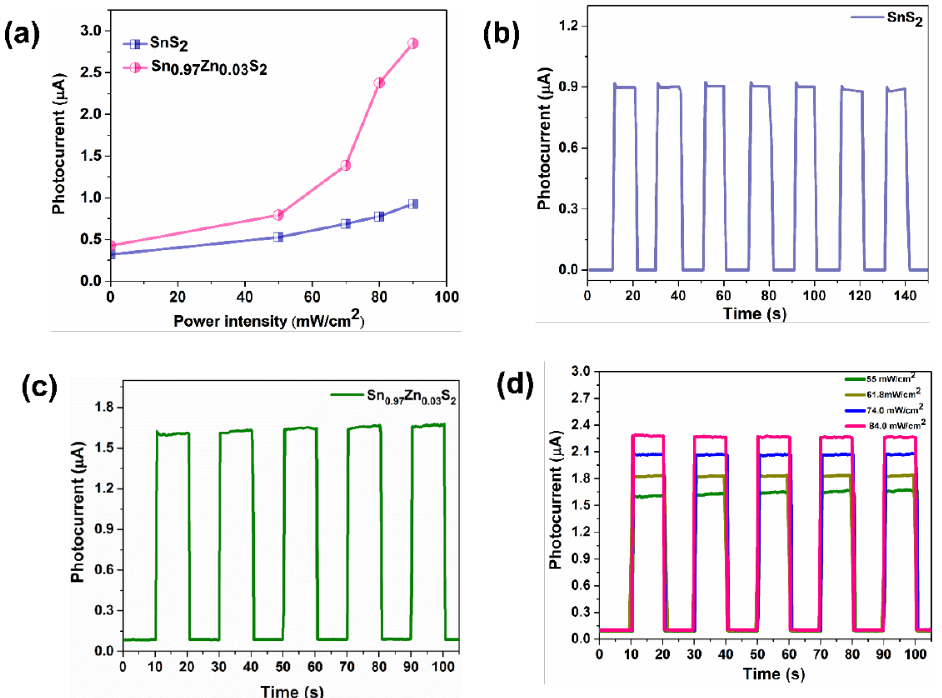
Figure 9. ( a ) Light intensity-dependent photocurrent values of pristine SnS 2 and Sn 0.97 Zn 0.03 S 2 device. Time-dependent photocurrent response of ( b ) SnS 2 device and ( c ) Sn 0.97 Zn 0.03 S 2 . ( d ) Time-dependent photocurrent response of Sn 0.97 Zn 0.03 S 2 device under different illumination intensities.